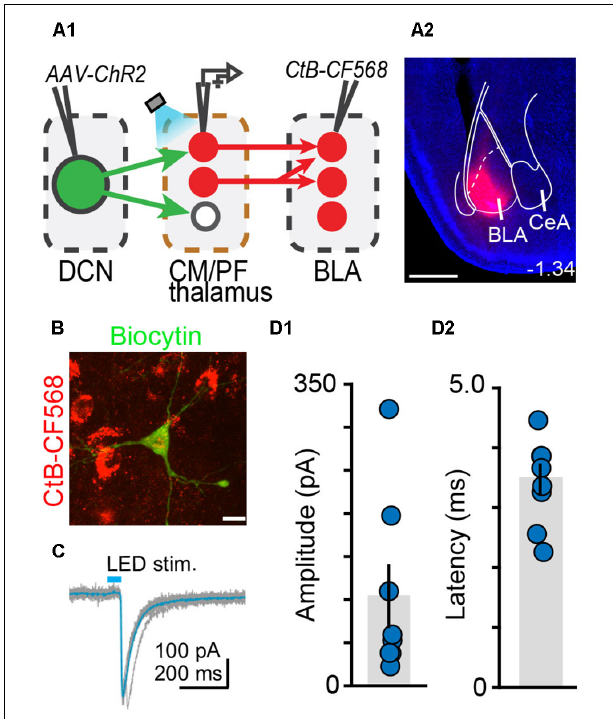
FIGURE 6 | The centromedial and parafascicular thalamus is a functional node of the cerebello-amygdala circuit. (A) Experimental approach (A1) and example CtB-CF568 injection in amygdala (A2) . Blue: DAPI. Scale bar: 500 µ m. (B) BLA-projecting neuron in centromedial (CM) thalamus retrogradely labeled with CtB CF-568 (red) is also labeled with biocytin (green) through the patch pipette. Scale bar: 10 µ m. (C) Example ChR2-evoked synaptic response. Average trace (teal) overlaid onto single trials (gray). (D1,D2) Average ( ± SEM) amplitude (D1) and onset latency (D2) of ChR2-evoked synaptic currents at DCN-CM/PF